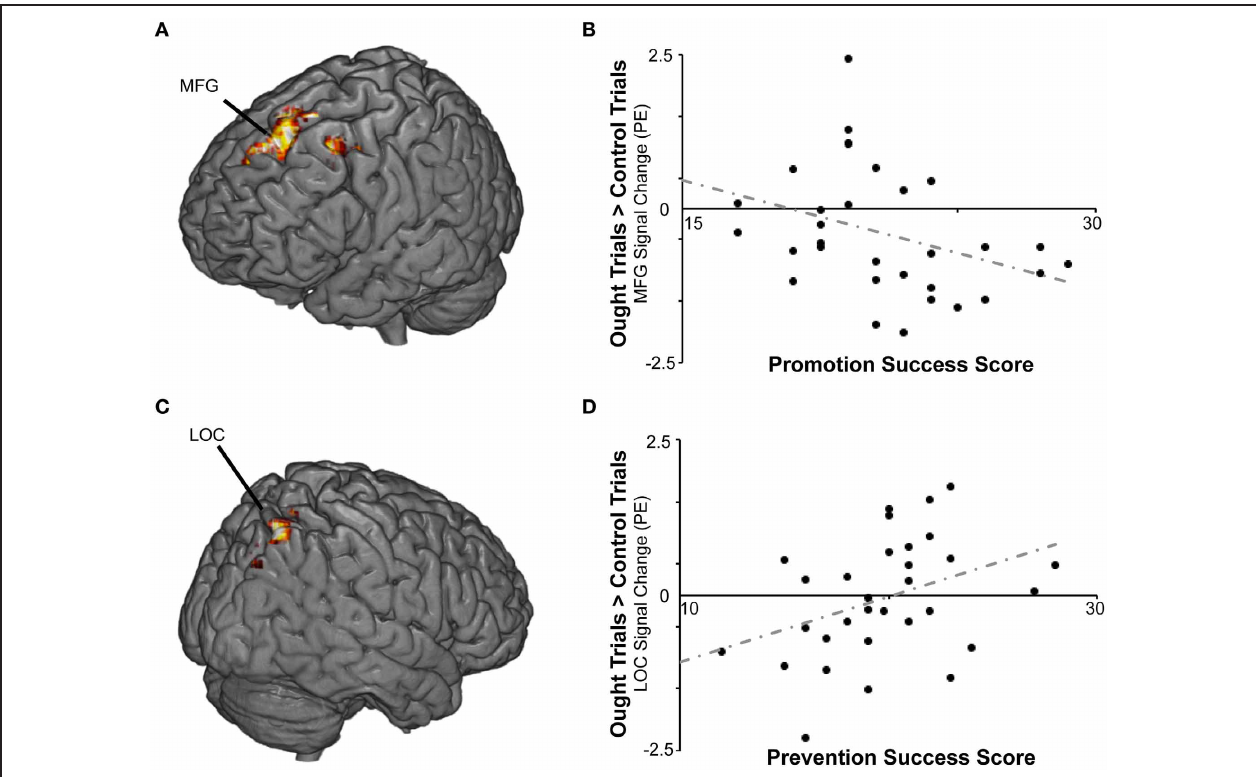
gyrus ( x − 32, y 14, z 46) as a function of promotion success scores. (C) For the ought > control contrast, prevention success scores were positively correlated with activation in lateral occipital cortex (LOC) and other regions. (D) The scatterplot displays mean standardized PEs at the right LOC ( x 36, y − 70, z 54) as a function of prevention success scores.